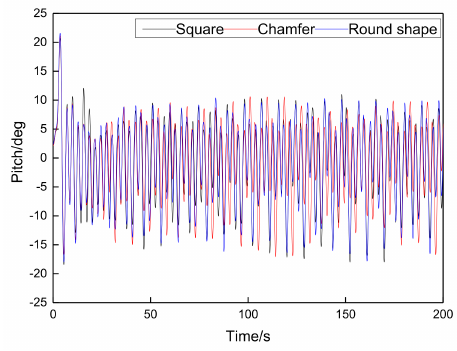
Figure 8. The angle change of the device in the pitch direction.